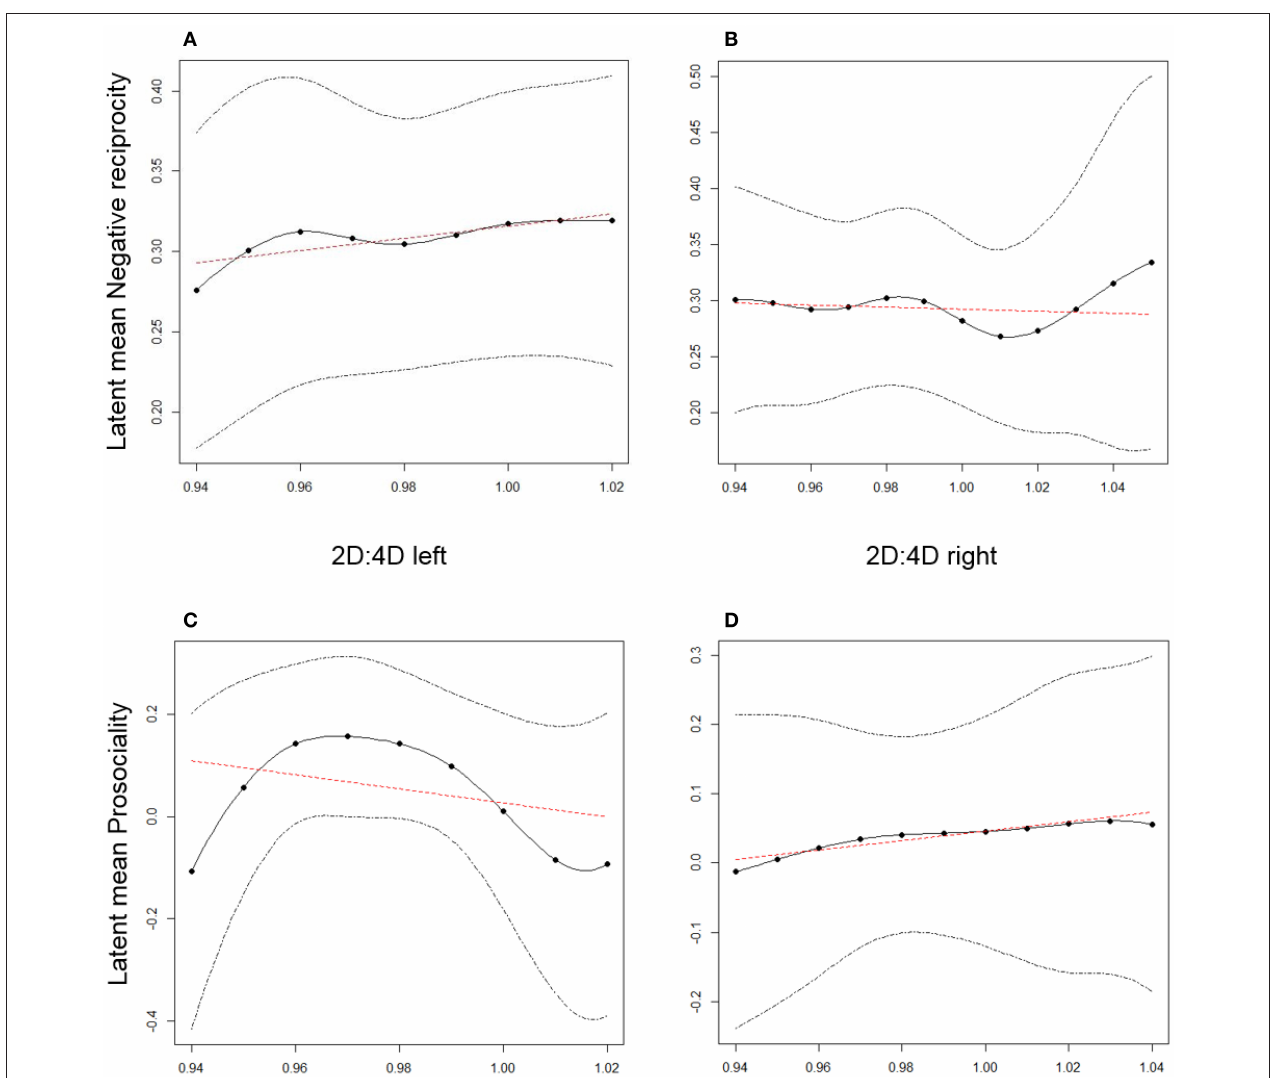
FIGURE 5 | Parameter gradients for latent factor means as estimated by Local Structural Equations to test non-linear associations between 2D:4D and prosociality. In (A,C) the x-axis depicts average values of the measured 2D:4D across the two raters at the left hand side. In (B,D) the x-axis depicts average values of the measured 2D:4D across the two raters at the right hand